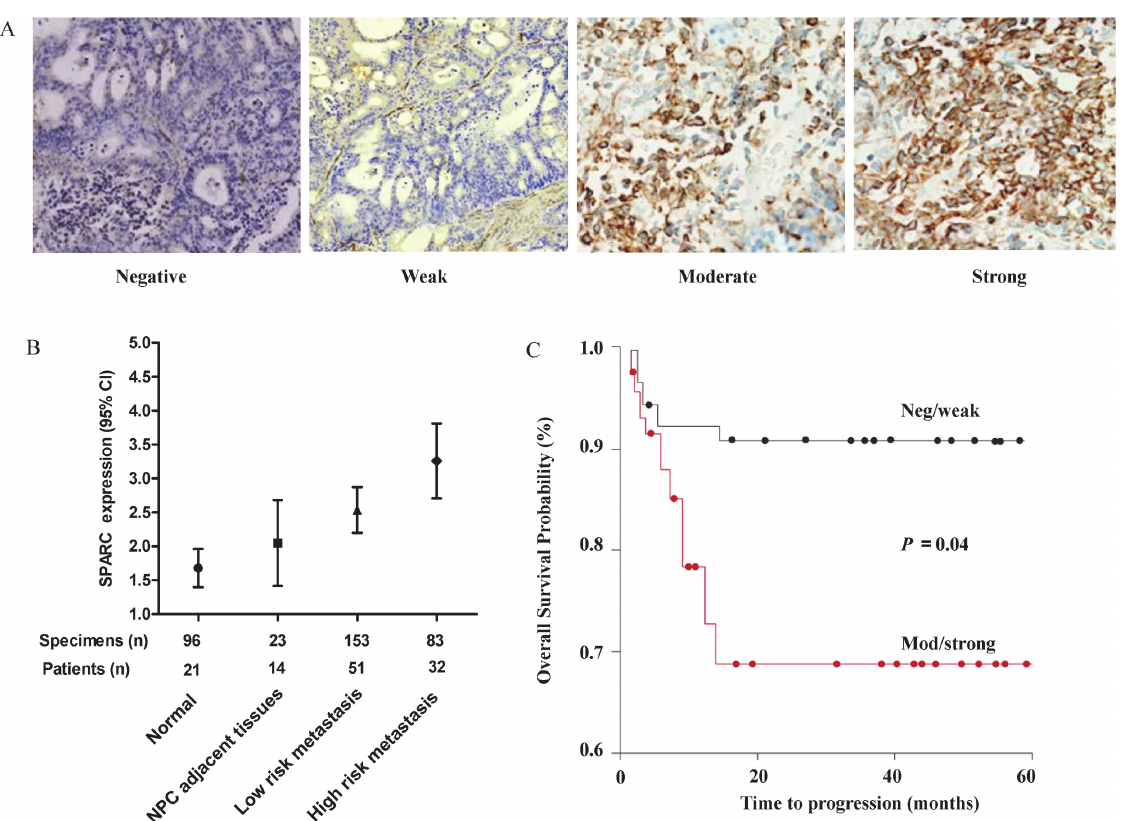
Fig 6. High SPARC expression correlates with shorter overall survival in NPC patients. (A) SPARC protein levels correlate with NPC aggressiveness. Representative tissue is stained with an antibody against NPC. Immunohistochemical stains show absent nuclear staining in normal samples (left, original magnification 100×), moderate and strong nuclear staining in NPC samples with low and high risk of metastasis (center right and right, respectively; original magnification 100×). Weak staining shown is a benign nasopharynx adjacent to NPC (center left, original magnification 100×). (B) Tissue analysis of SPARC expression for each tissue spot. The mean SPARC protein expression for the indicated NPC tissues is summarized using error bars with 95% confidence intervals, demonstrating a significantly lower score in NPC with a high risk of metastasis compared with non-malignant controls (Mann-Whitney test, two- tailed, p < 0.001). (C) The OS of patients with low SPARC expression levels was significantly higher than that of patients with high SPARC expression levels (log rank test, p =